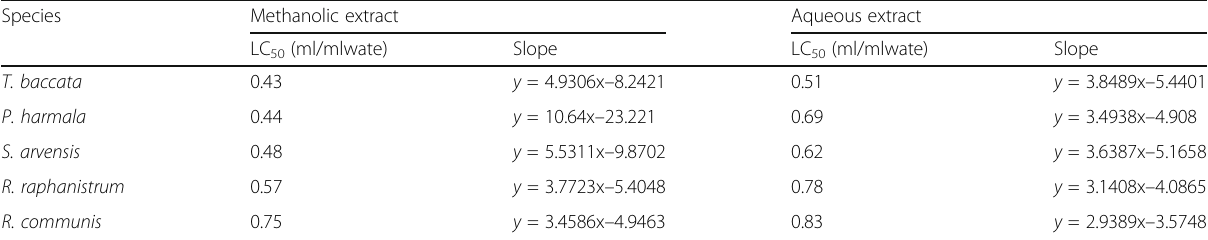
Table 2 Lethal concentration 50 (LC 50 ) of the effect of extracts on M.incognita J2s mortality after 32 h of treatment